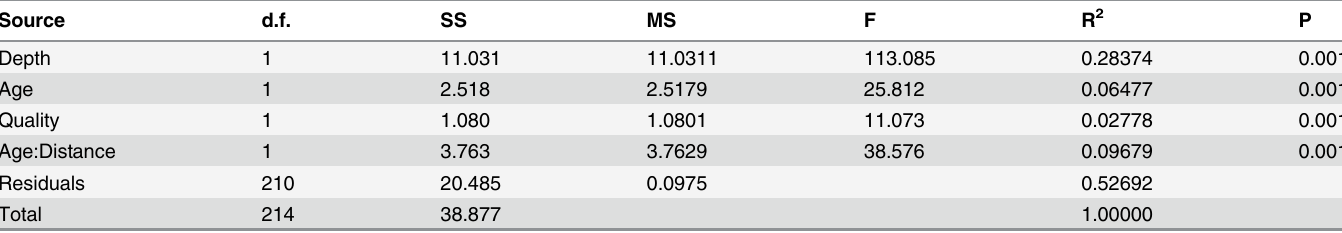
Table 9. PERMANOVA on variables that influence species assemblages